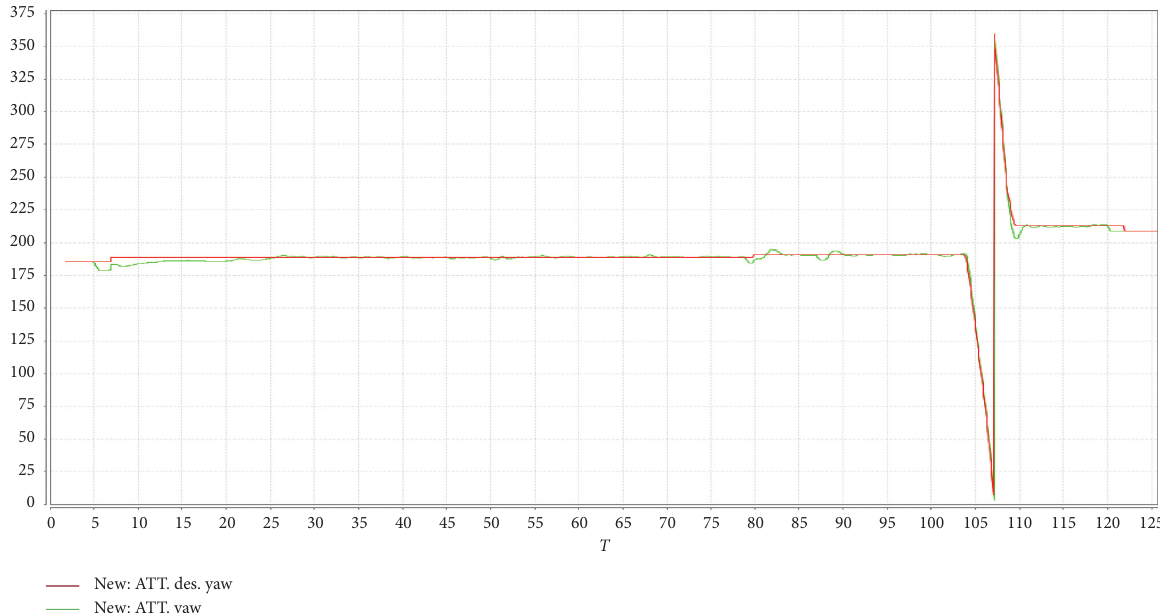
Figure 17: Actual flight yaw angle graph.